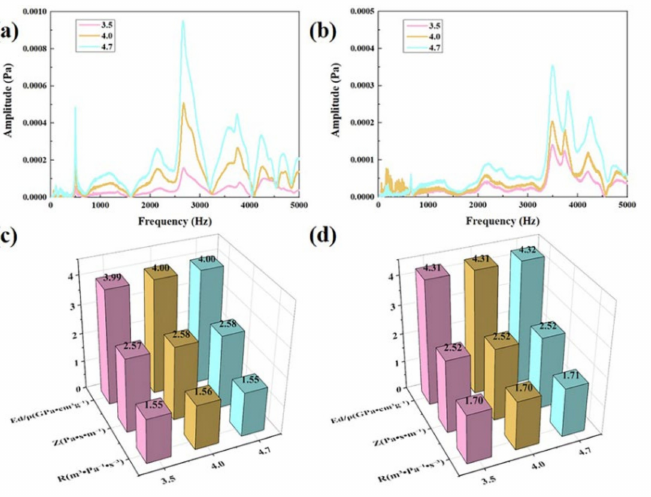
Figure 3. Frequency spectra induced by different impulses in composites: ( a ) hemp; ( b ) ramie. Acoustic vibration performance parameters under different vibration impulses: ( c ) hemp; ( d )